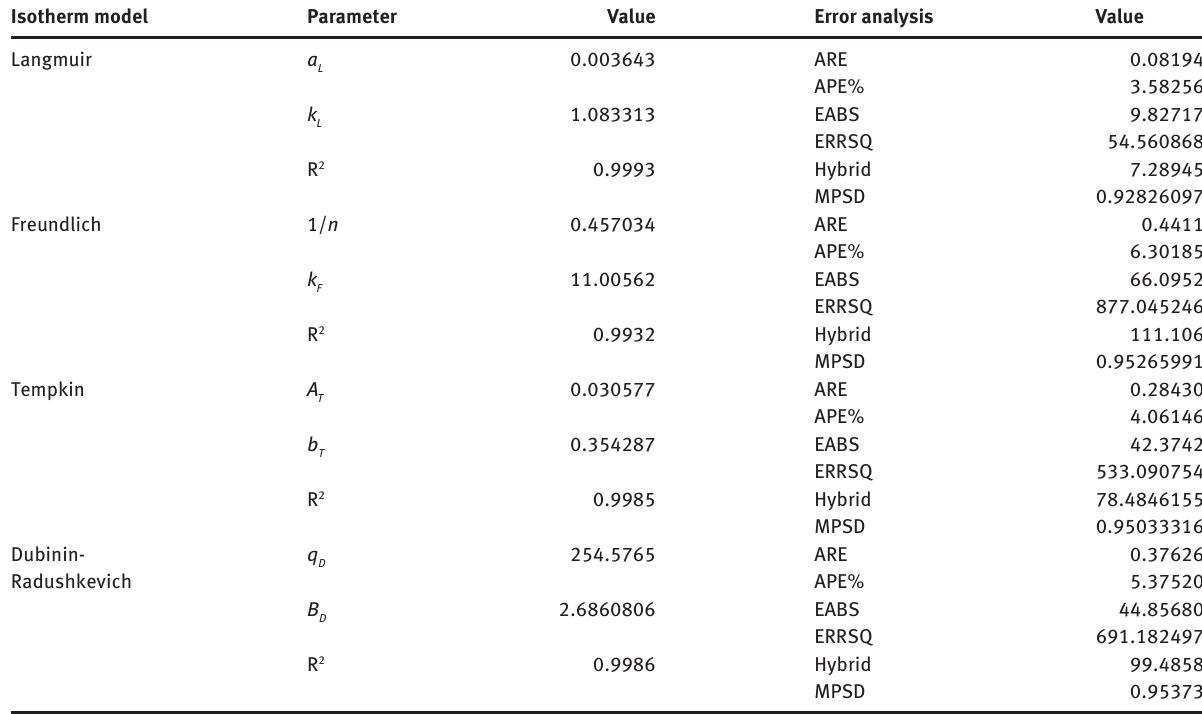
Table 2: Constants and error analysis of two-parameter models for adsorption of Pb(II) onto S. sesban L. at 30 ° C. Isotherm model